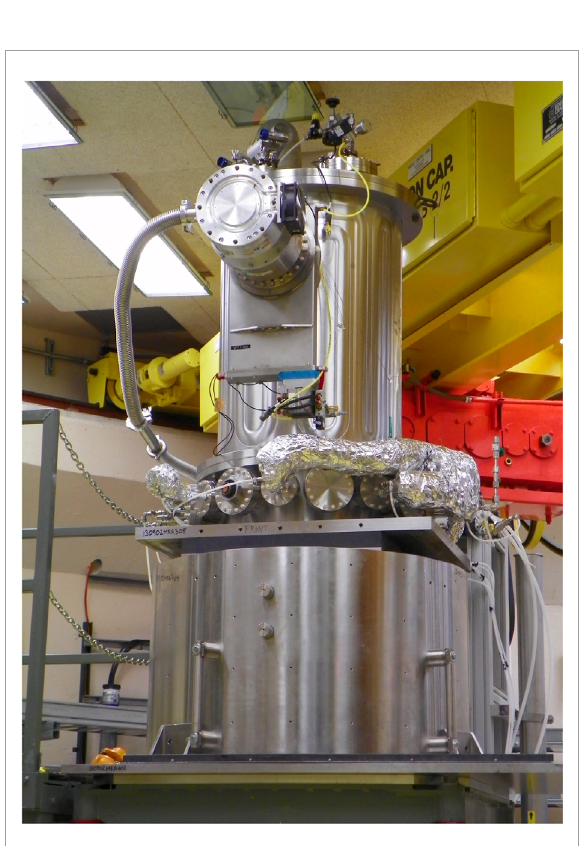
FIGURE 10 Photo of the KRUSTY experiment on the Comet